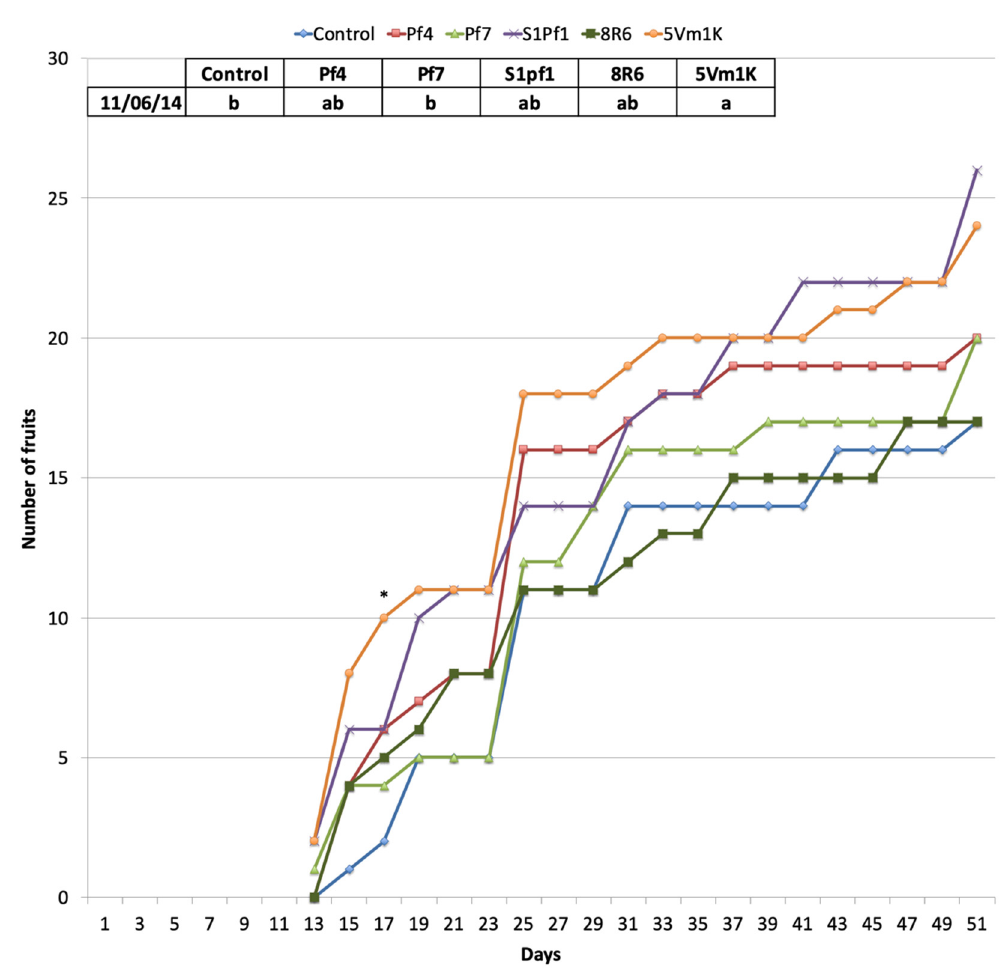
Figure 3. The number of fruits produced by zucchini plants inoculated or not with the five PGPBs during two months of growth. The * indicates a sampling time where significant differences among the treatments were observed; in the table, the different letters indicate significant differences among the treatments according to the Kruskal–Wallis test followed by the Dunn test ( p < 0.05).